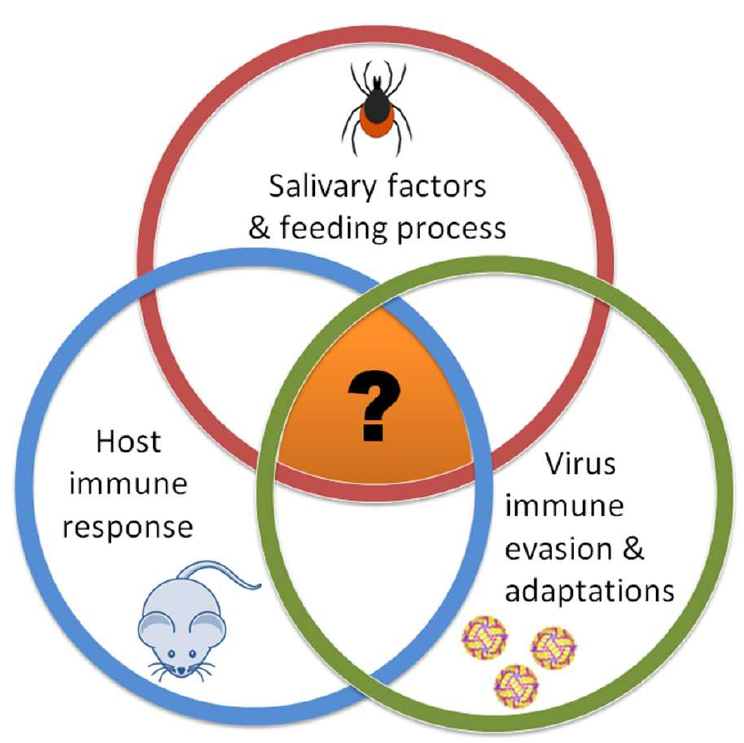
Figure 1. Interactions between tick-borne flaviviruses, tick vectors, and vertebrate hosts. The orange region with the question mark represents the cutaneous interface, which is the initial site where viruses gain access to a host or a vector.